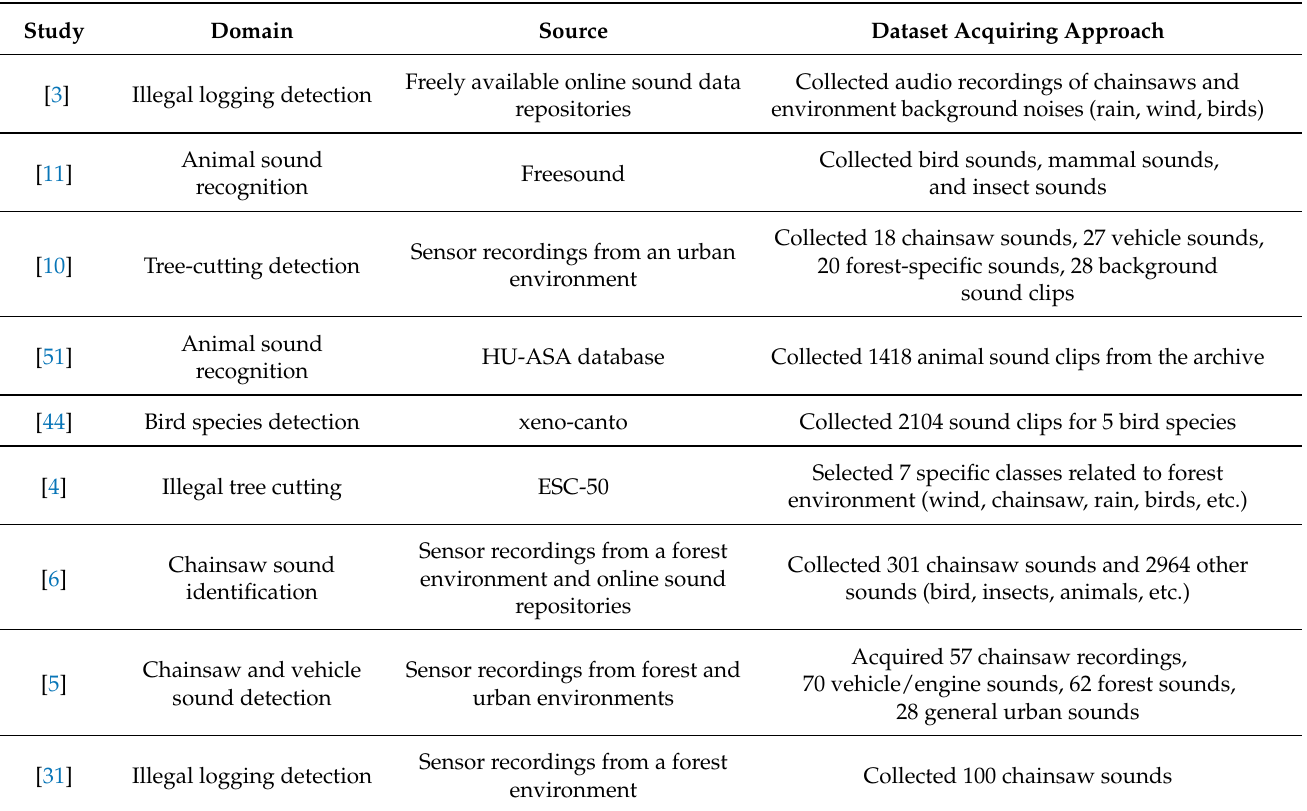
Table 4. Sound acquisition approaches in related